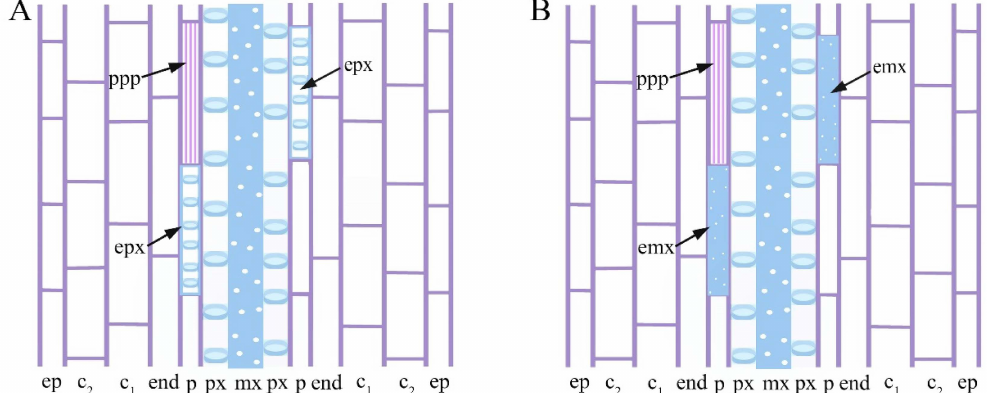
Figure 5. ( A , B ) Scheme showing the radial longitudinal section of the basal portion of the hypocotyl of a seedling of Arabidopsis thaliana (Col ecotype) cultured for 9 days under continuous darkness followed by 7 days under 16 h light/8 h darkness with either 1 nM 24-epibrassinolide (eBL) ± 60 µ M of CdSO 4 (Cd) ( A ) or with 1 µ M eBL ( B ). Note that the ectopic protoxylem elements (epx, arrows in A ) and the ectopic metaxylem elements (emx, arrows in B ) are scattered in the pericycle periclinal proliferated (PPP, arrows) cells. The tissues external to the primary xylem of the vasculature are indicated by the abbreviations: ep, epidermis; c 1 and c 2 , cortical layers; end, endodermis; p,